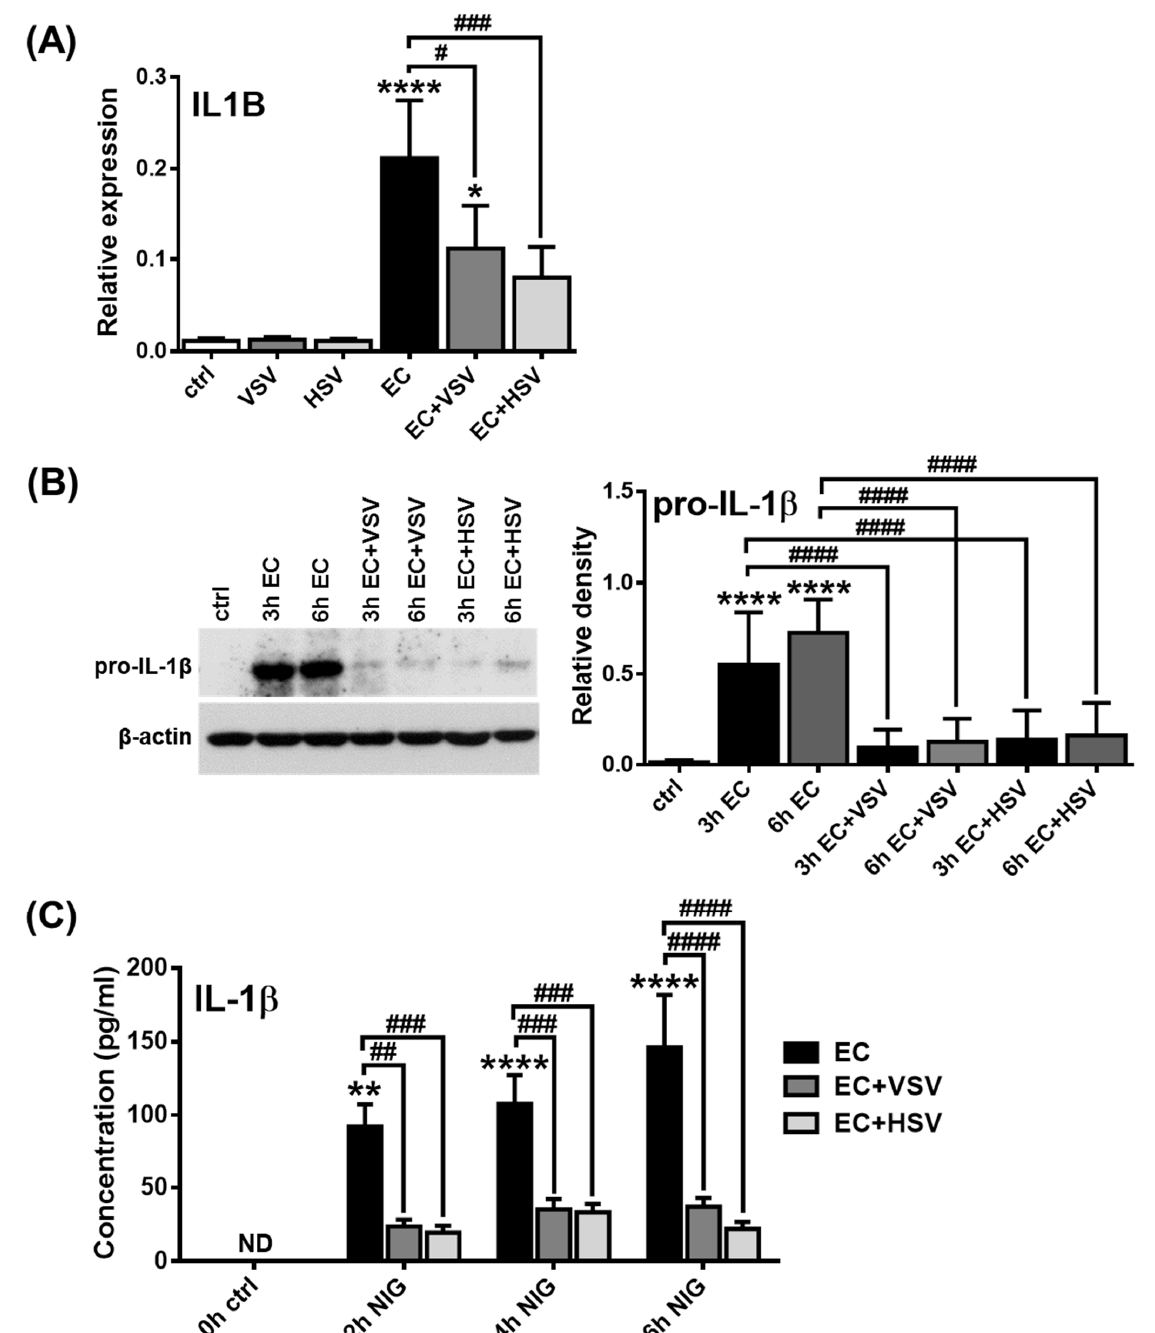
Figure 7. Viral pretreatment inhibits the IL-1 β production in the human GEN2.2 cell line. GEN2.2 cells were incubated in the presence of VSV or HSV at a MOI of 10 for 3 h. Then cells were activated with E. coli (MOI 10) for 3 or 6 h ( A – C ). To induce IL-1 β secretion E. coli -treated cells were incubated in the presence of 20 µ M nigericin in a time-dependent manner ( C ). The expression of IL1B was determined at the mRNA level by qPCR ( A ) and at the protein level by Western blotting ( B ) and ELISA ( C ). A representative blot is shown in ( B ). Bar graphs represent the mean ± SD of 4 independent experiments. Data were analyzed using one-way ANOVA followed by Bonferroni’s post-hoc test. * p < 0.05, ** p < 0.01, **** p < 0.0001 vs. control (ctrl), # p < 0.05, ## p < 0.01, ### p < 0.001, #### p < 0.0001. VSV: Vesicular Stomatitis Virus , HSV: Herpes Simplex Virus , EC: Escherichia coli , NIG: nigericin, ND: not